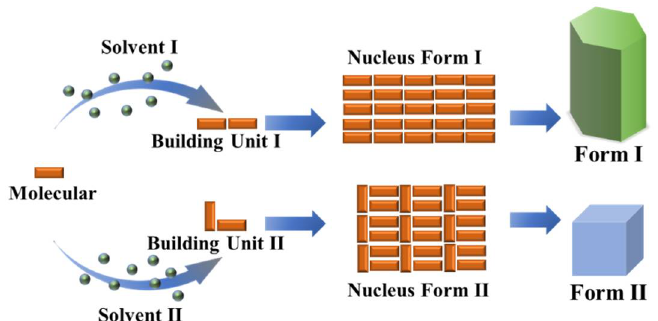
Figure 5. Schematic representation of solvent-dependent self-association and polymorphic crystal- lization.